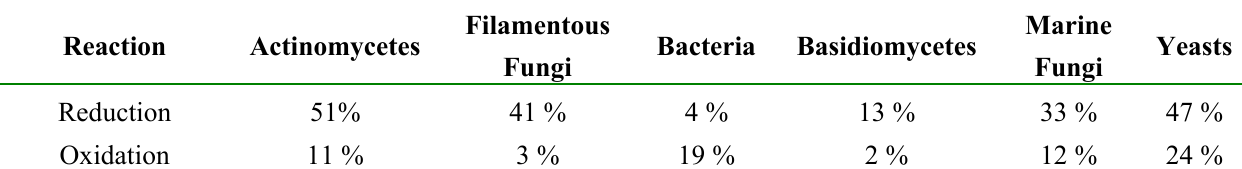
Table 3. Percentage of microorganisms of each taxonomic group that present activity in the reduction or in the oxidation reactions